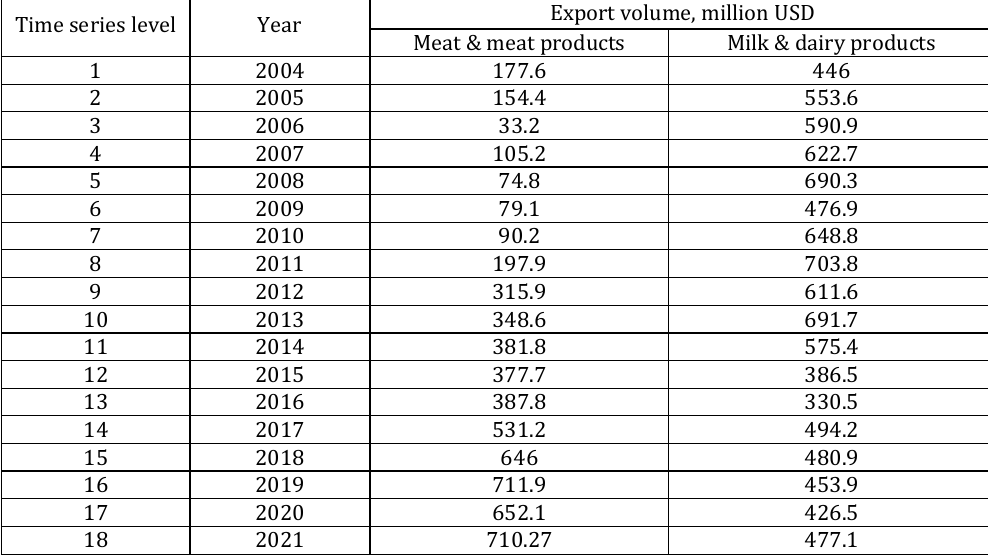
Table 4. Dynamics of export volumes of dairy and meat products of the livestock sector during 2004-2021 (Source: